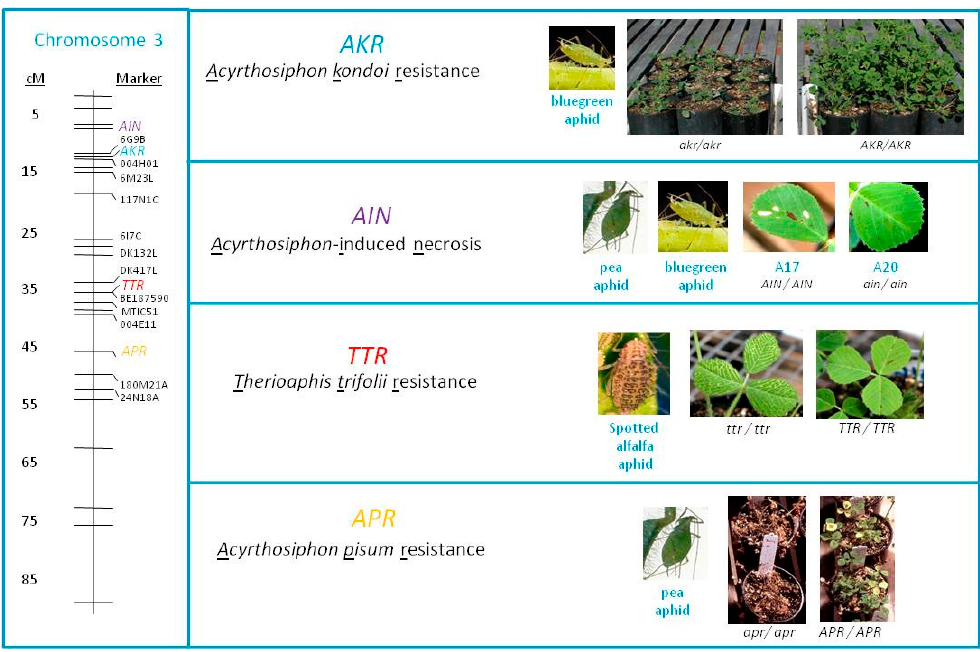
Figure 3. Overview of the major resistance genes identified in M. truncatula cv. Jester to three different aphid species.